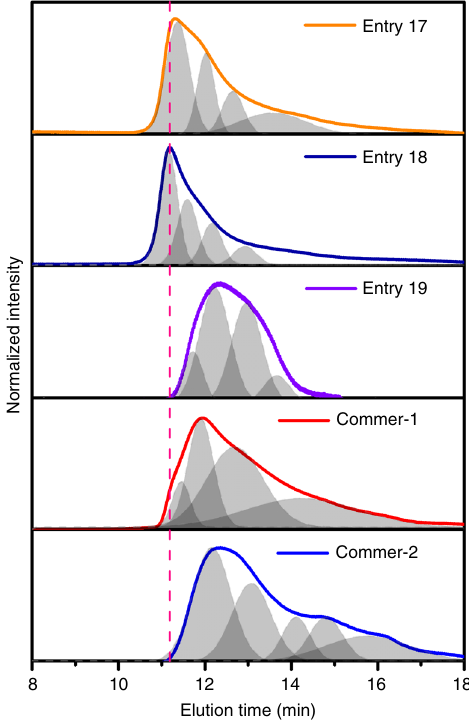
Fig. 3 GPC data for test batches and commercial polymers. The multiple curves were deconvoluted through the fi tting of each GPC